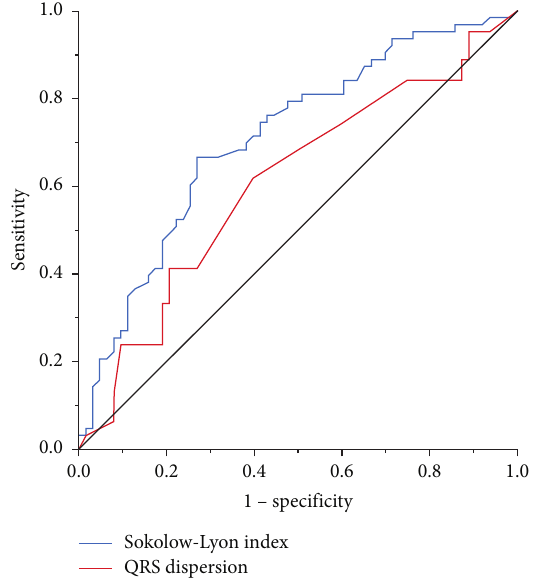
Figure 1: ROC curve for two electrocardiographic parameters to discriminate between pre- and